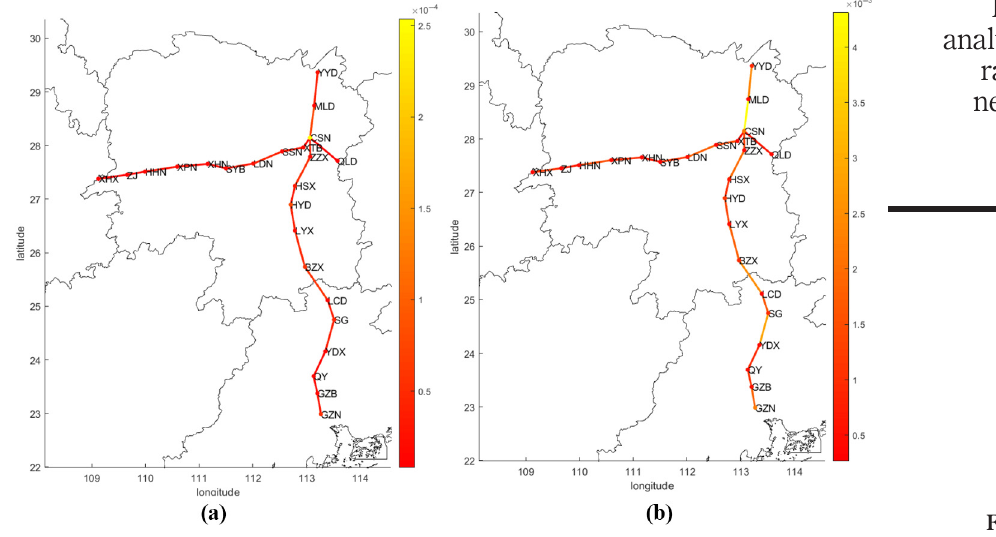
Figure 3. Expected loss of